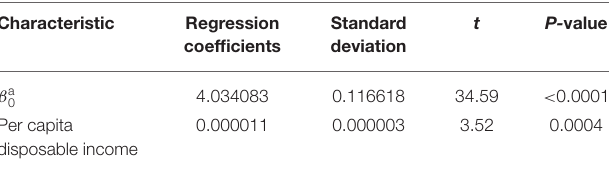
FIGURE 3 | Spatial distribution of the mean per capita disposable income at the county-level. TABLE 2 | Spatial regression analysis of the serum SELENOP and per capita disposable